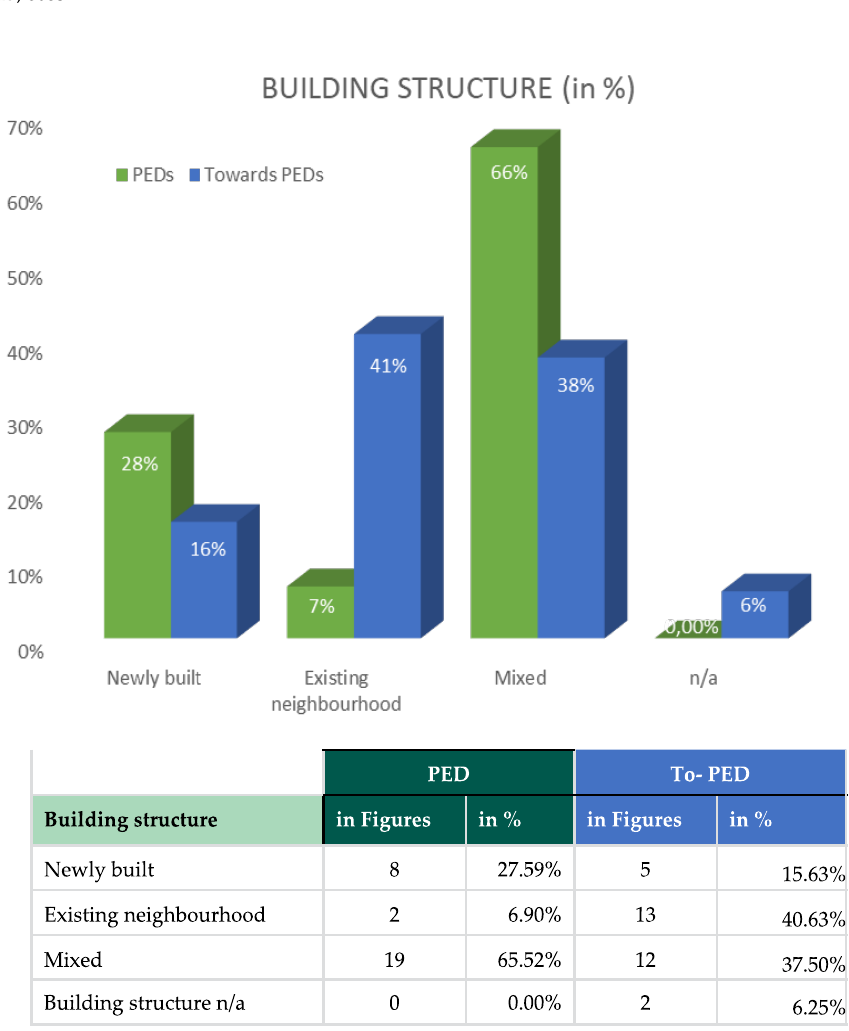
Figure 2. Building structure of PED versus To-PED.